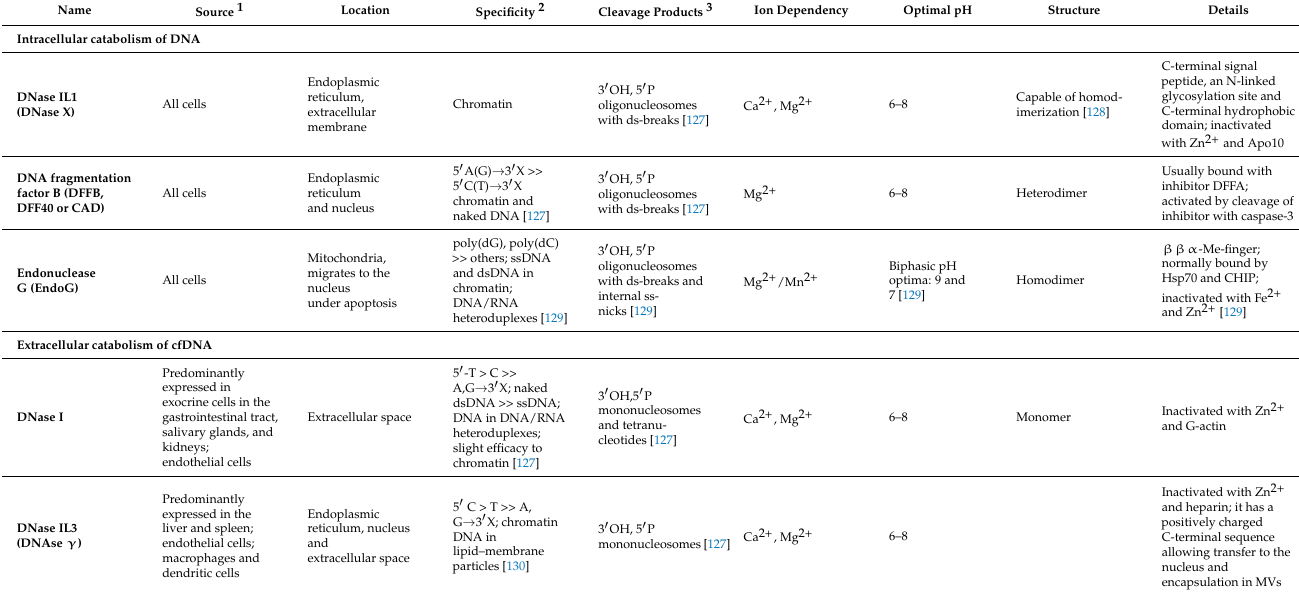
Table 1. DNases providing intracellular and extracellular catabolism of